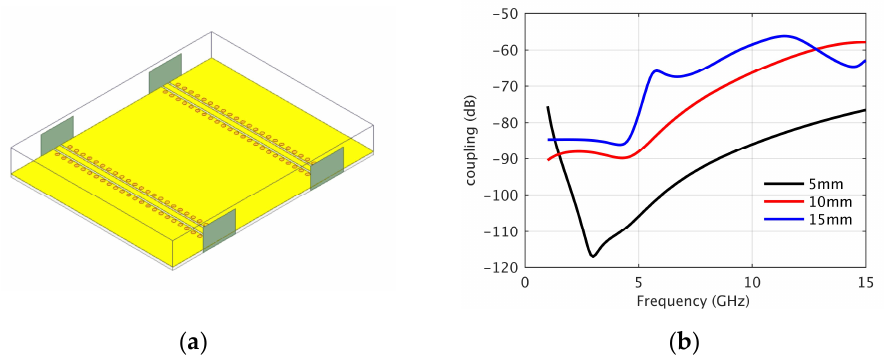
Figure 14. ( a ) Two-channel IF transmission line model. ( b ) Simulation results in different lengths.